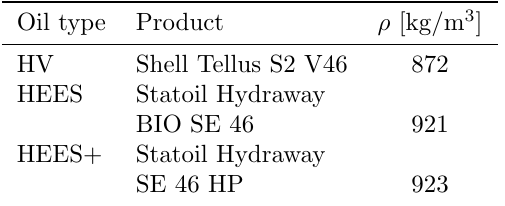
Table 1: Oils used for testing,(Shell, 2013),(Statoil, 2013a),(Statoil, 2013b).